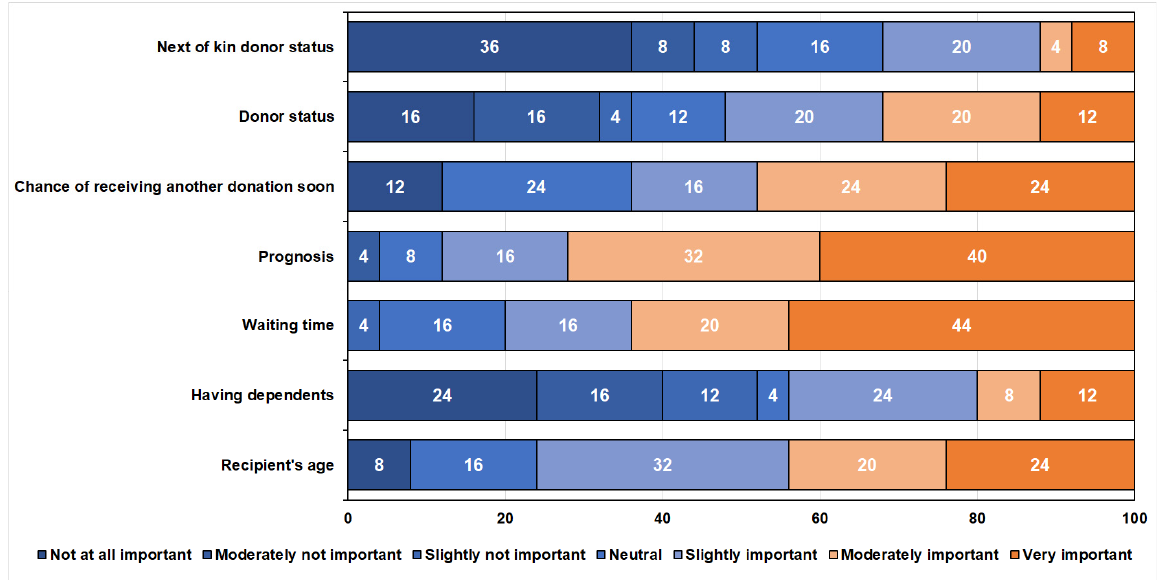
Figure 1. Importance of organ allocation parameters in percentage. Table 3. Analysis of organ allocation criteria.